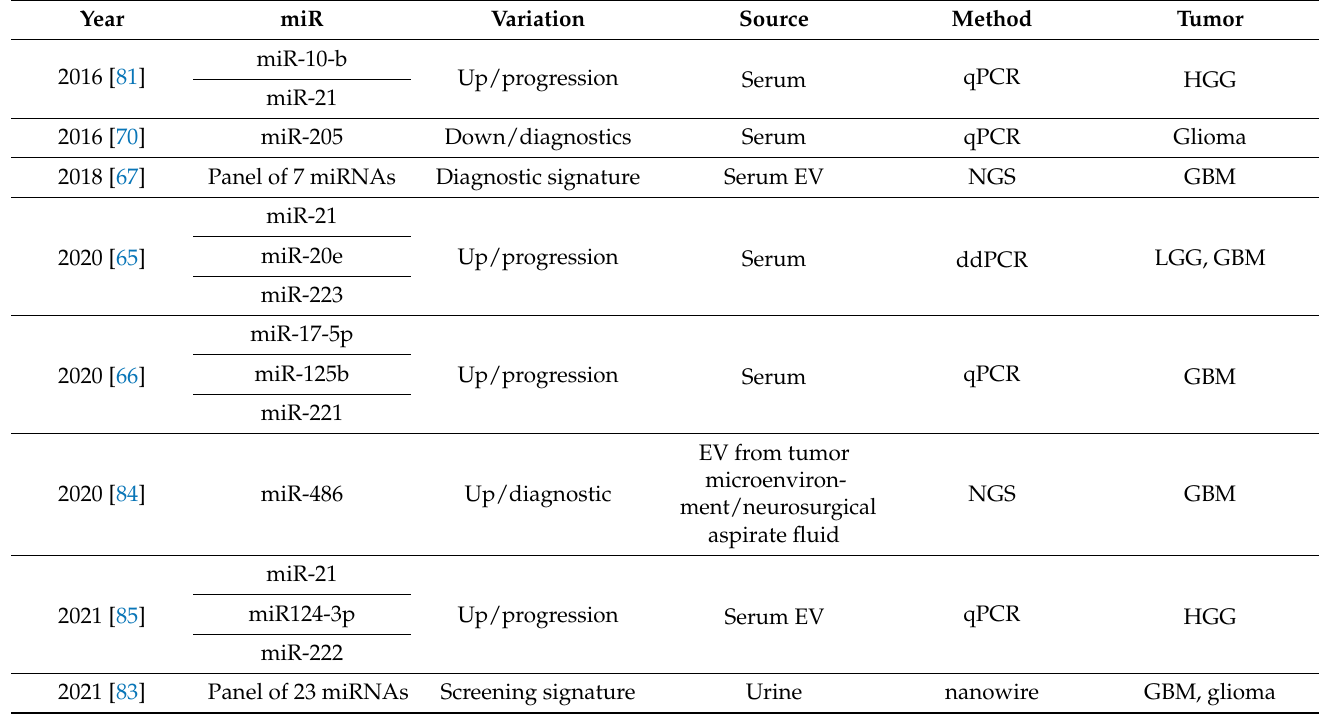
Table 3. Examples of circulating miRNA markers in brain